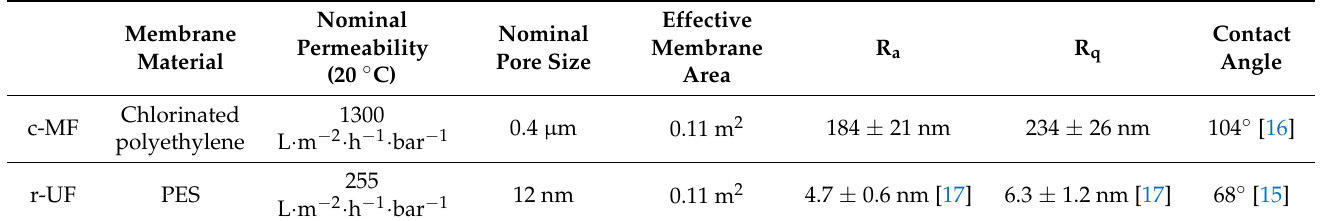
Table 1. Commercial microfiltration (c-MF) and recycled ultrafiltration (r-UF) membranes’ techni- cal data.